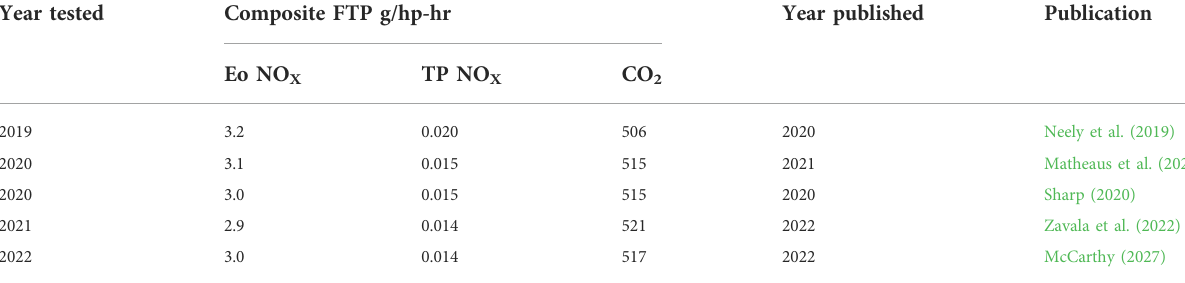
TABLE 2 Demonstrated 2027 emissions using CDA, LO-SCR, and primary aftertreatment over four (4) calendar years. Year